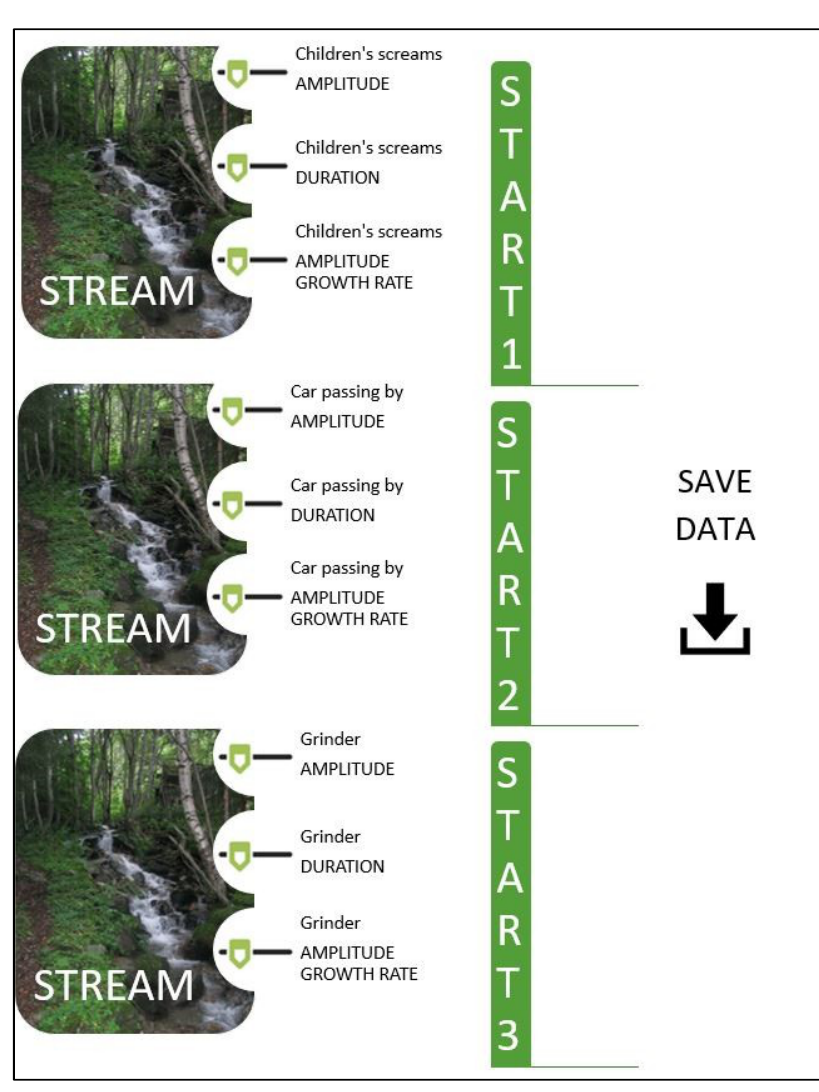
Figure 5. A flowchart with the steps of the experiment procedure.